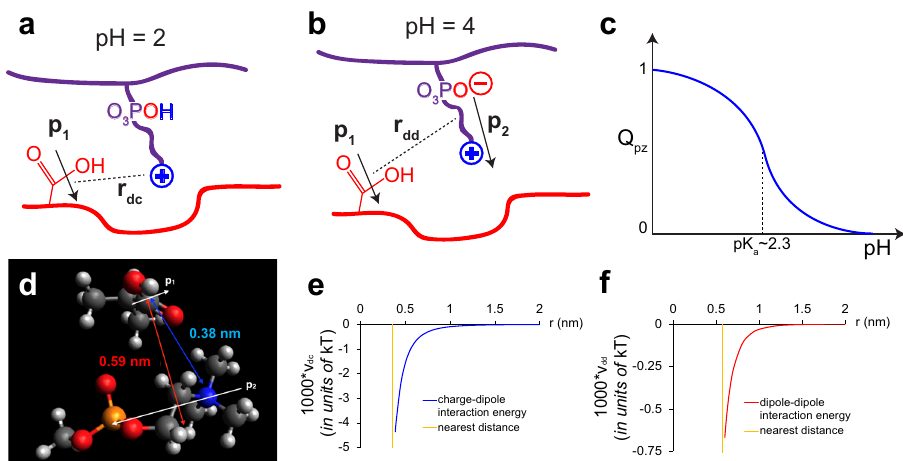
Fig. 2 Schematics of the electrostatic interaction between pAA and pMPC. a At low pH (~2), the repeat unit of pAA (red) is deionized and acts as a dipole, while the phosphoryl group of the zwitterionic repeat unit of pMPC (purple) is deionized so that the monomer acts as a positive charge, resulting in dipole-charge interaction at separation distance r dc . This attractive energy, in combination with counterion release, leads to complexation. b Schematic of the electrostatic interaction between pAA and pMPC at pH ~ 4. The pAA monomer is again deionized and acts as a dipole. However, the phosphoryl group of pMPC is ionized so that the monomer is electrically neutral and thus, also acts as a dipole. The net effect is a weak dipole-dipole interaction between pAA and pMPC. c Since the pK a of the phosphoryl group is 2.3 and the charge on the ammonium group is fi xed, the net charge Q pZ of the zwitterion changes from + 1 to zero as the pH is increased from 2 to 4. d Snapshot of the packing model of a repeat unit of pAA and that of pMPC from the Avogadro software. The closest distance between the dipolar pAA and the charged pMPC is 0.38 nm; for the dipolar zwitterion it is 0.59 nm. e Plot of the dipole- charge interaction energy per contact (blue curve) as a function of their separation distance ( ℓ B = 0.7 nm, p 1 = 0.0354, and κ = 0.329 nm − 1 at pH 2). The orange vertical line represents the nearest distance between the charge and the dipole, 0.38 nm. f Plot of dipole-dipole interaction energy per contact (red curve) as a function of their separation distance; ℓ B = 0.7 nm, p 1 = 0.0354, p 2 = 0.39, κ = 0.0329 nm − 1 at pH 4. The orange line represents the nearest distance between dipoles, 0.59